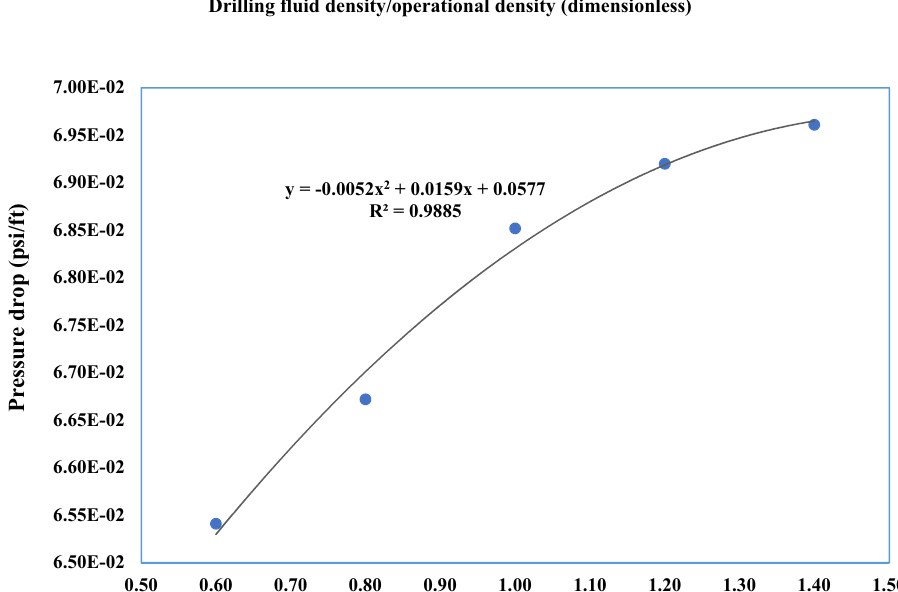
Drilling fluid density/operational density (dimensionless)